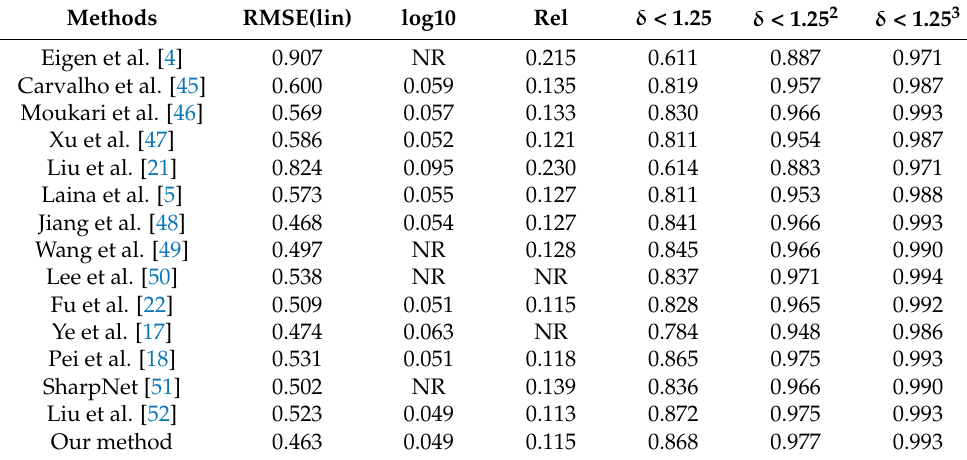
Table 1. Quantitative comparison results on NYU dataset.